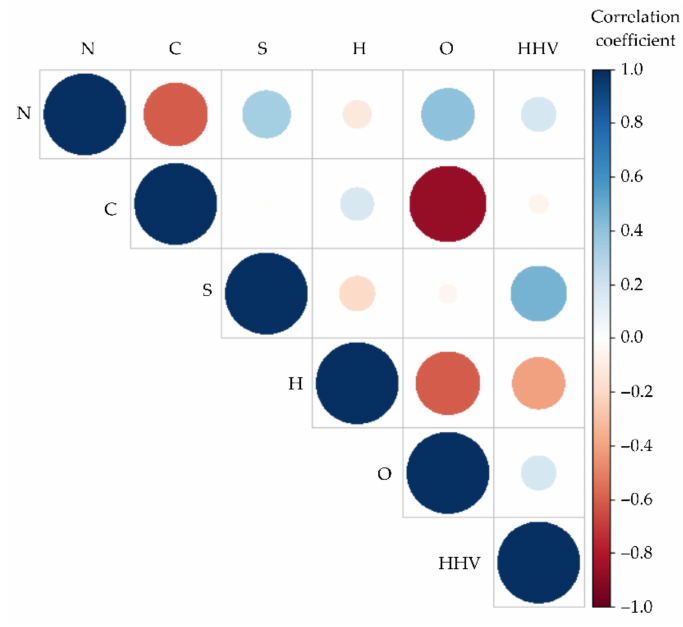
Figure 2. Correlation plot of observed